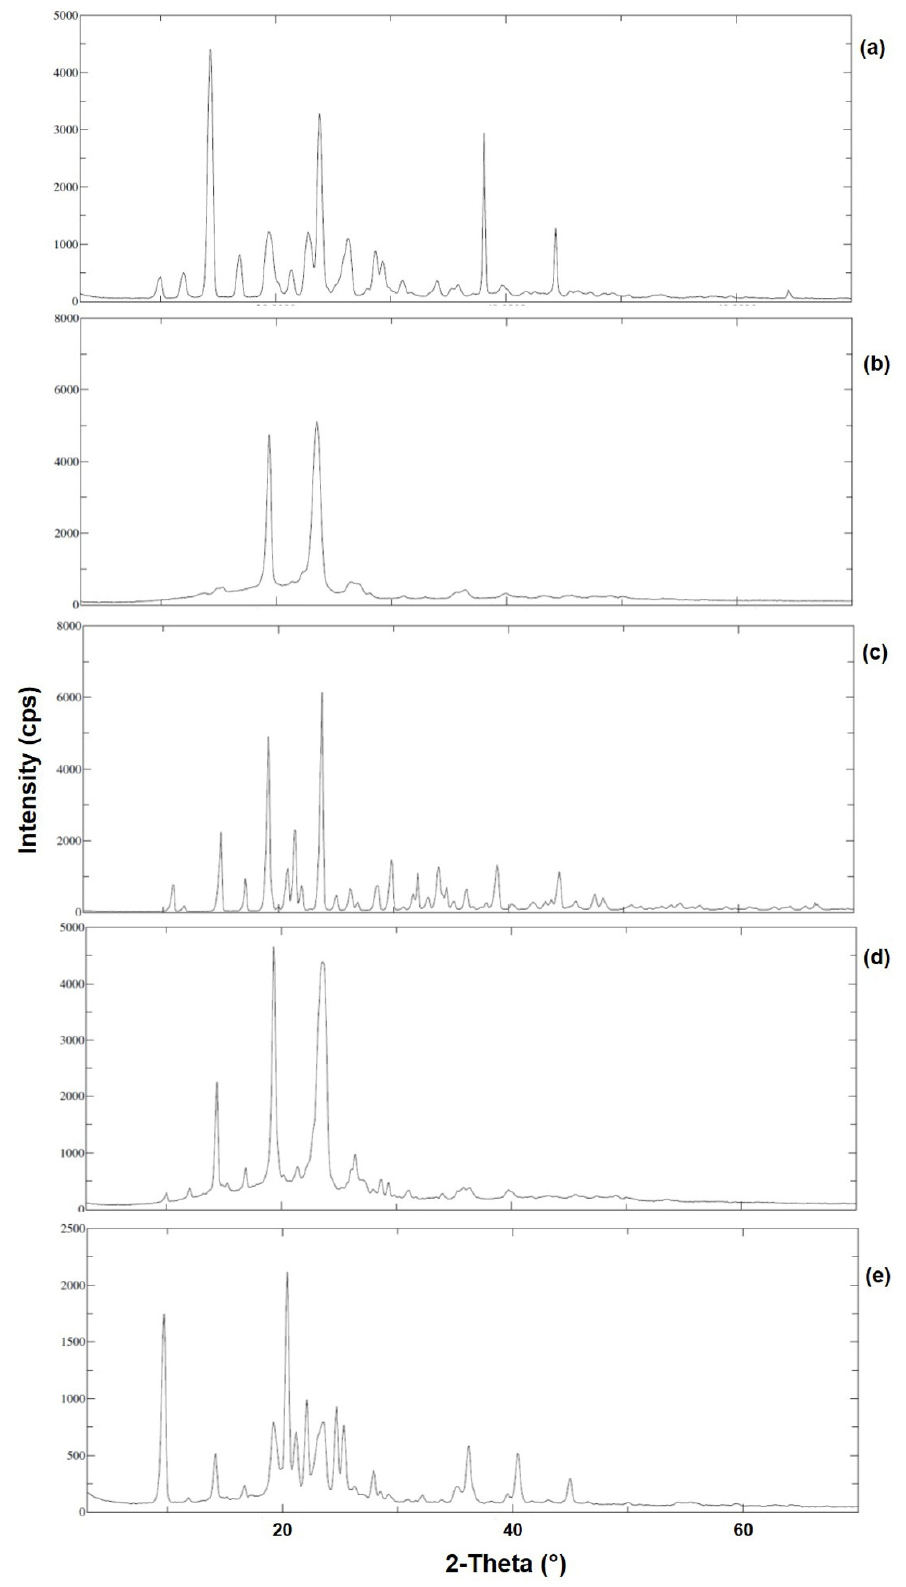
Figure 7. XRD patterns of pure TZP ( a ), P188 ( b ), mannitol ( c ), PM of TZP, P188 and mannitol ( d ) and lyophilized NC 1 ( e ).